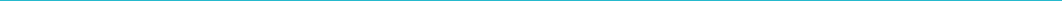
Figure 1: Role of angiotensin converting-enzyme-2 (ACE2) in the renin-angiotensin-aldosterone system (RAAS). The main metabolic pathway of the RAAS is driven by the angiotensin-converting enzyme ACE and the main effects are exerted by angiotensin II (AngII) via the angiotensin II type 1 receptor (AT 1 ). The effects can be inhibited by ACE inhibitors (ACEI) or by AT 1 receptor blockers (ARB). The effects of Ang II are balanced (1) by a simultaneous stimulation of Ang II type 2 receptors (AT 2 ), which exert regulatory effects and (2) by ACE2 that cleaves Ang II into angiotensin-(1–7) (Ang-(1–7)) which exerts its effects via the MAS receptor (MAS). The biological effects of this second ax- is through ACE2/Ang-(1–7)/MAS counteract or modulate the effects of the classical axis